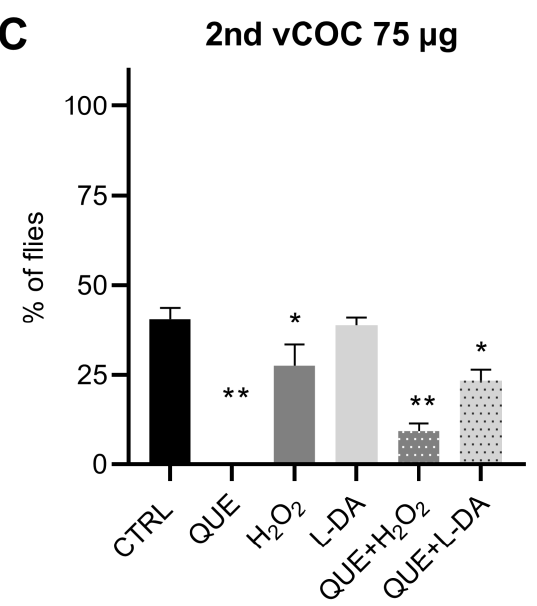
Figure 6. QUE feeding prevents development of locomotor sensitization to vCOC. wt flies without treatment (CTRL), orally fed for 24 h with 4.80 mM quercetin (QUE), 130 mM hydrogen peroxide (H 2 O 2 ), 5 mM L-3,4-dihydroxyphenylalanine (L-DA), or a combination of QUE (4.80 mM) + H 2 O 2 (130 mM) and QUE (4.80 mM) + L-DA (5 mM). ( A ) Hydrogen peroxide (H 2 O 2 ) concentration was measured in head homogenates at 09:00 in triplicate ( n = 9). ( B ) Percent of individual flies that increase locomotor activity relative to baseline activity after single exposure to 75 µ g vCOC at 09:00 (sensitivity). ( C ) Percent of individual flies that increase locomotor activity relative to baseline activity after single exposure at 09:00 and further increase activity after the second exposure at 15:00 to 75 µ g vCOC (locomotor sensitization). Data show five replicates ( n = 160) as average ± standard error mean (SEM). *: p < 0.05 and **: p < 0.01. One-way ANOVA with Tukey’s multiple comparison post-hoc